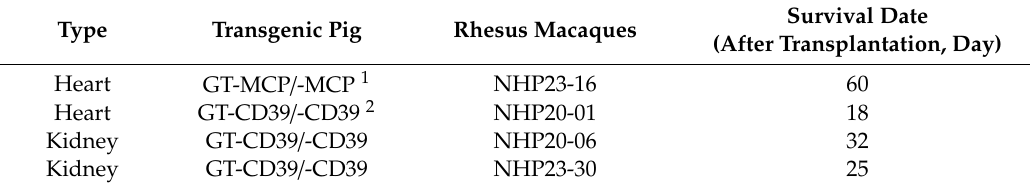
Table 1. Information about pigs for xenotransplantation.